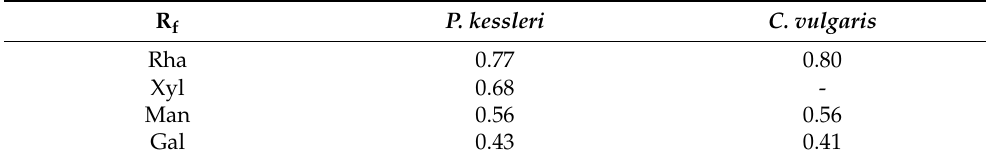
Table 2. Monosaccharide composition of EPS synthesized by P. kessleri and C. vulgaris . Retention factor (Rf) is the distance travelled by an individual component divided by the total distance travelled by the solvent. R f